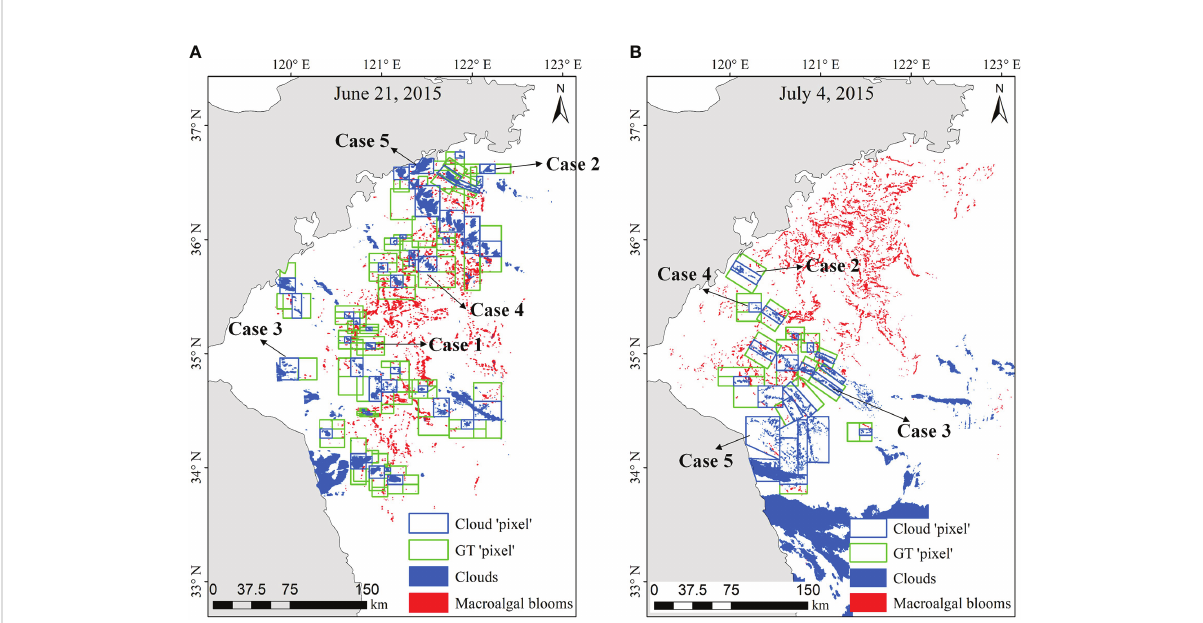
FIGURE 7 Application of the simple method for estimating macroalgae area under clouds under complex scenarios. (A) The scenario including four above cases; (B) The scenario including all above cases.